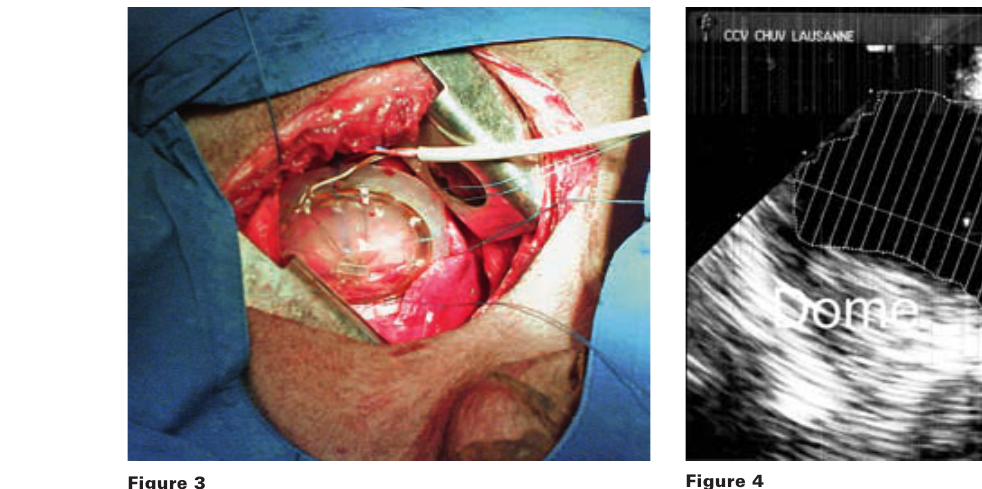
Intra-operative view of the dome, being sewed and